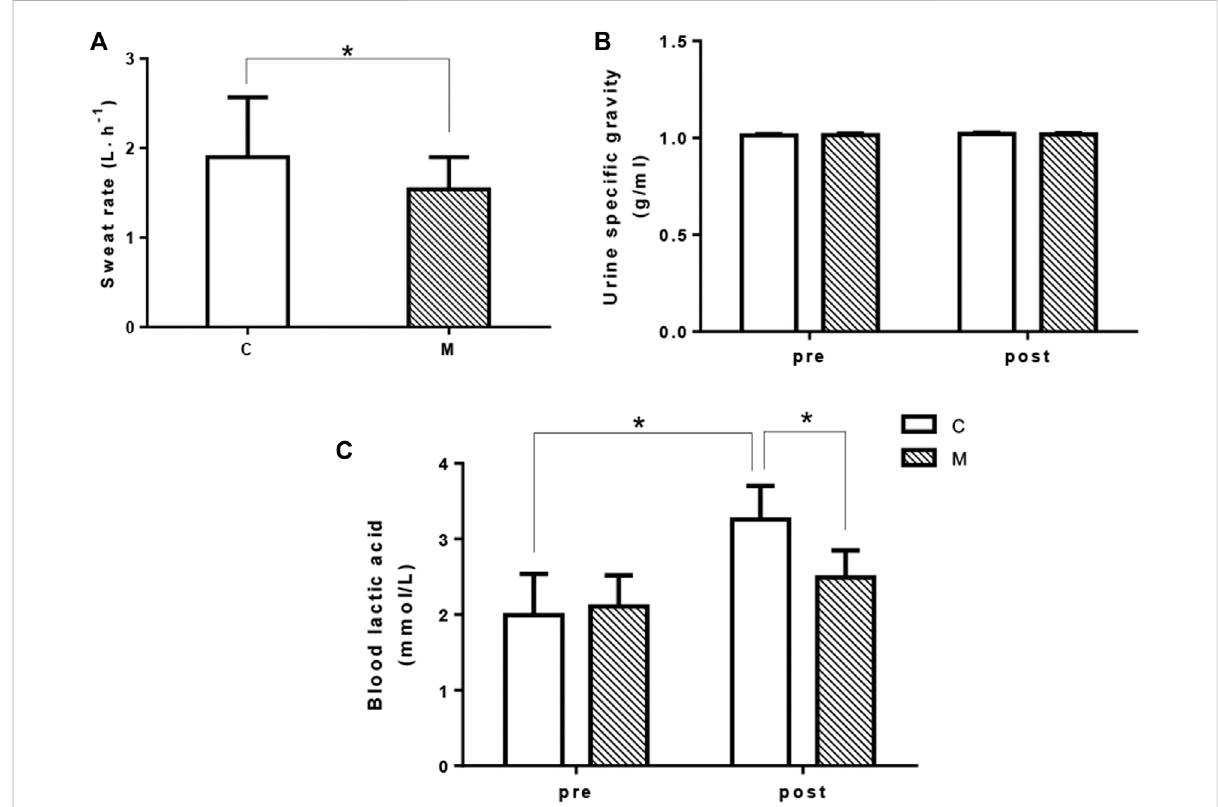
FIGURE 4 Changes in sweat rate (A) , urine speci fi c gravity (B) , and blood lactic acid (C) in the simulated tennis match between CON and MCOOL conditions. *Indicates p < 0.05 between groups. All values are presented as Mean ± SD. M, mixed-cooling condition; C, control